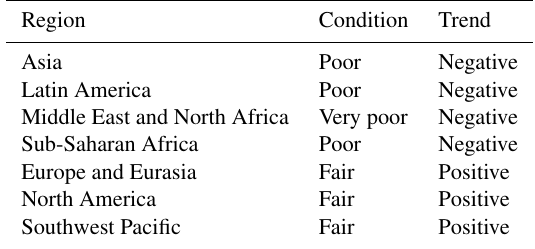
Table 1. Conditions and trends with respect to soil erosion as as- sessed by experts (data from FAO and ITPS,